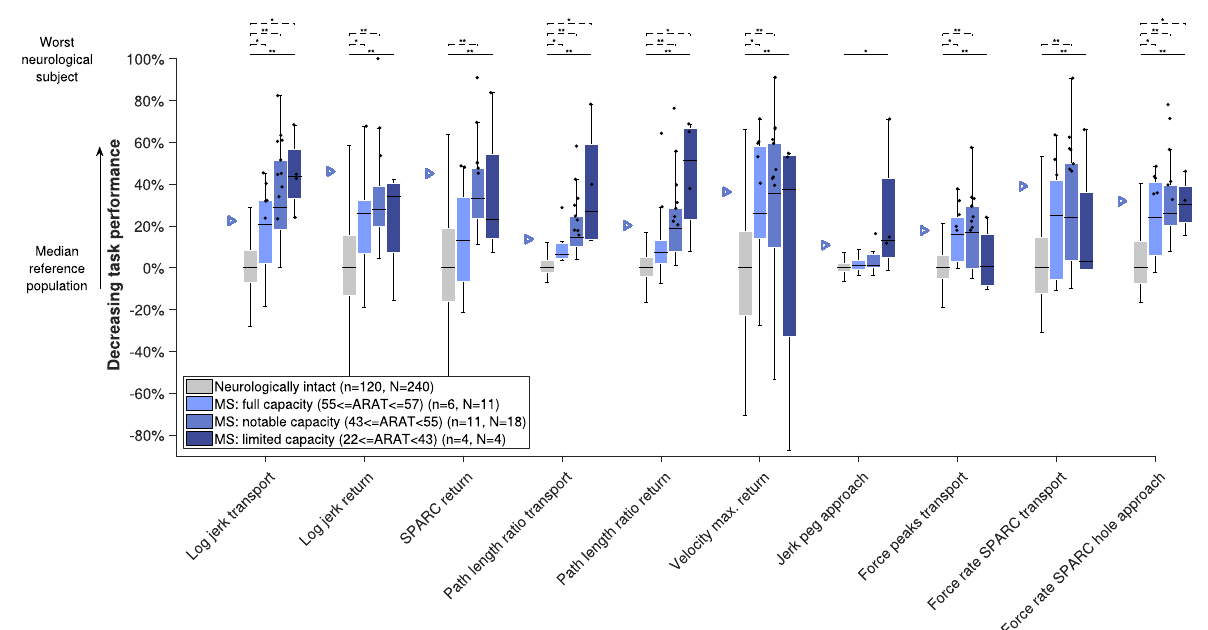
Fig. 5 Sensitivity of metrics to disability severity in MS subjects. See Fig. 4 for a detailed description. ARAT action research arm